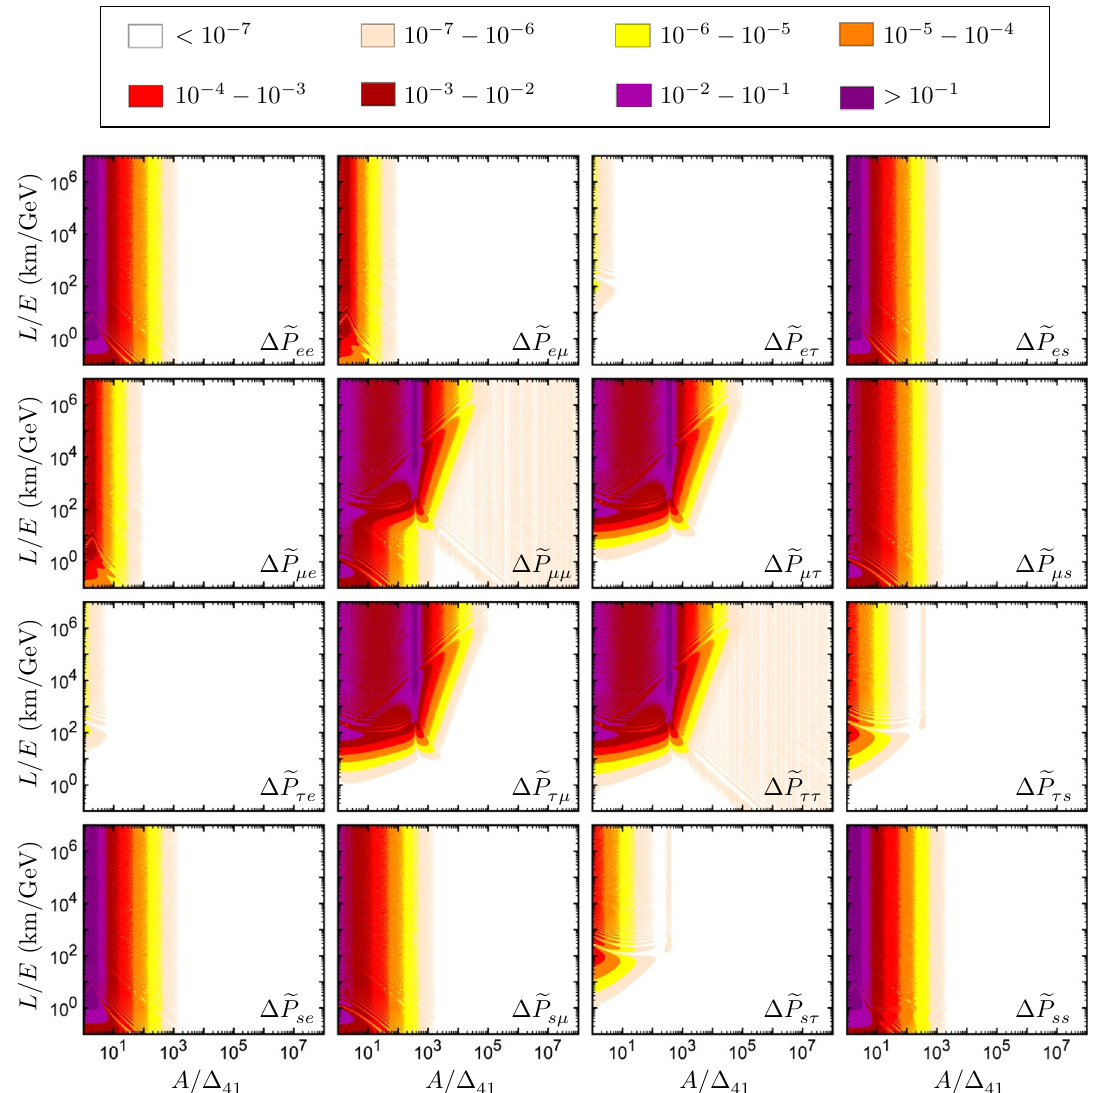
Figure 9 . The absolute errors of our analytical approximations in eq. (3.21), where the best-(cid:12)t values of ( (cid:18) ; (cid:18) ; (cid:18) ; (cid:14); (cid:1) ; (cid:1) ) in refs. [36, 37] have been input, ( (cid:18) 12 13 23 21 31 (cid:14) = (cid:14) = (cid:14) = 0, (cid:1) = 1 : 32 eV 2 [40] and (cid:15) 14 24 34 41